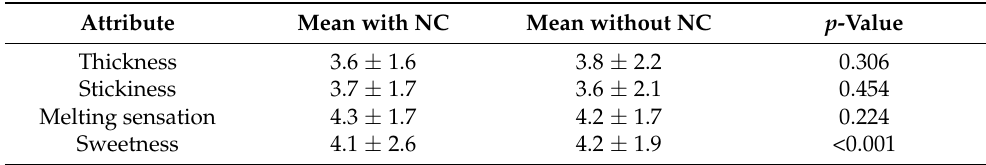
Table 3. Mean and standard deviation in thickness, stickiness, melting sensation, and sweetness among all the samples ( n = 40 × 5). The p -value indicates the difference between evaluations with and without nose clip (NC) among all the samples by paired t -test.